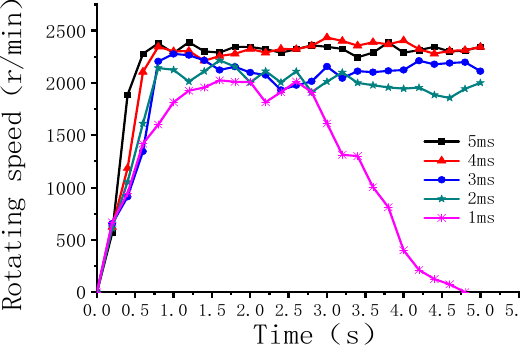
Figure 17. Rotation speed for different magnetization pulse widths during a cold start.